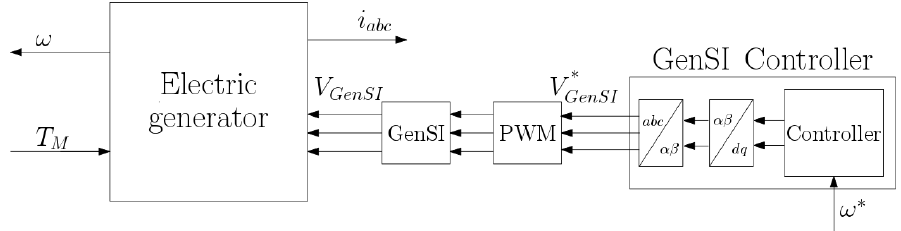
Figure 9. Diagram of the electric generator validation system, including the generator-side inverter and the controller, showing the inputs and the